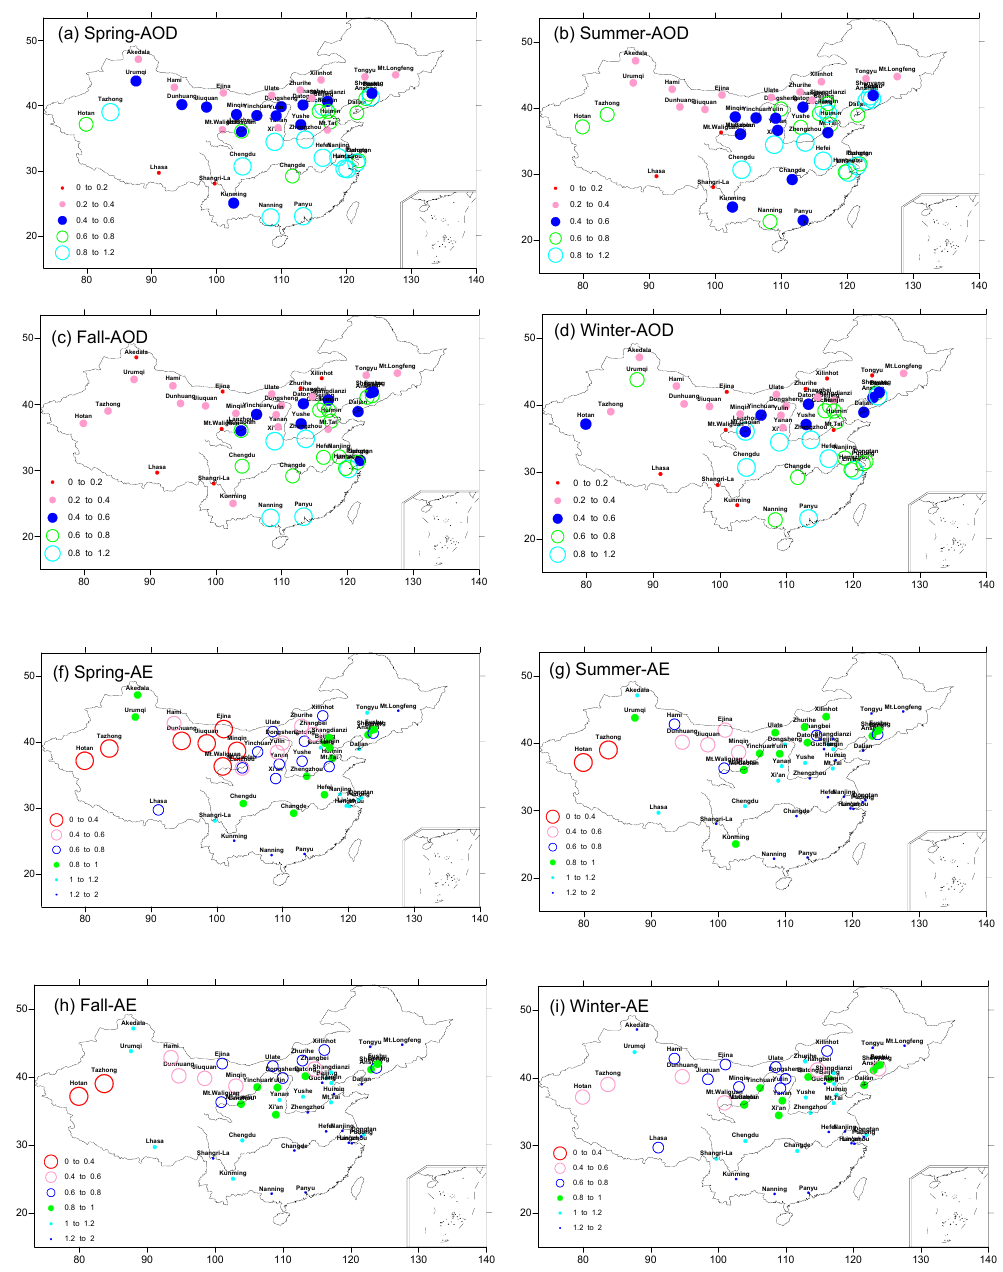
Figure 3. Seasonally stratified spatial distributions of AOD at 440nm ( a spring; b summer; c fall; and d winter) and AE between 440 and 870nm ( e spring; f summer; g fall; and h winter) based on CARSNET measurements.